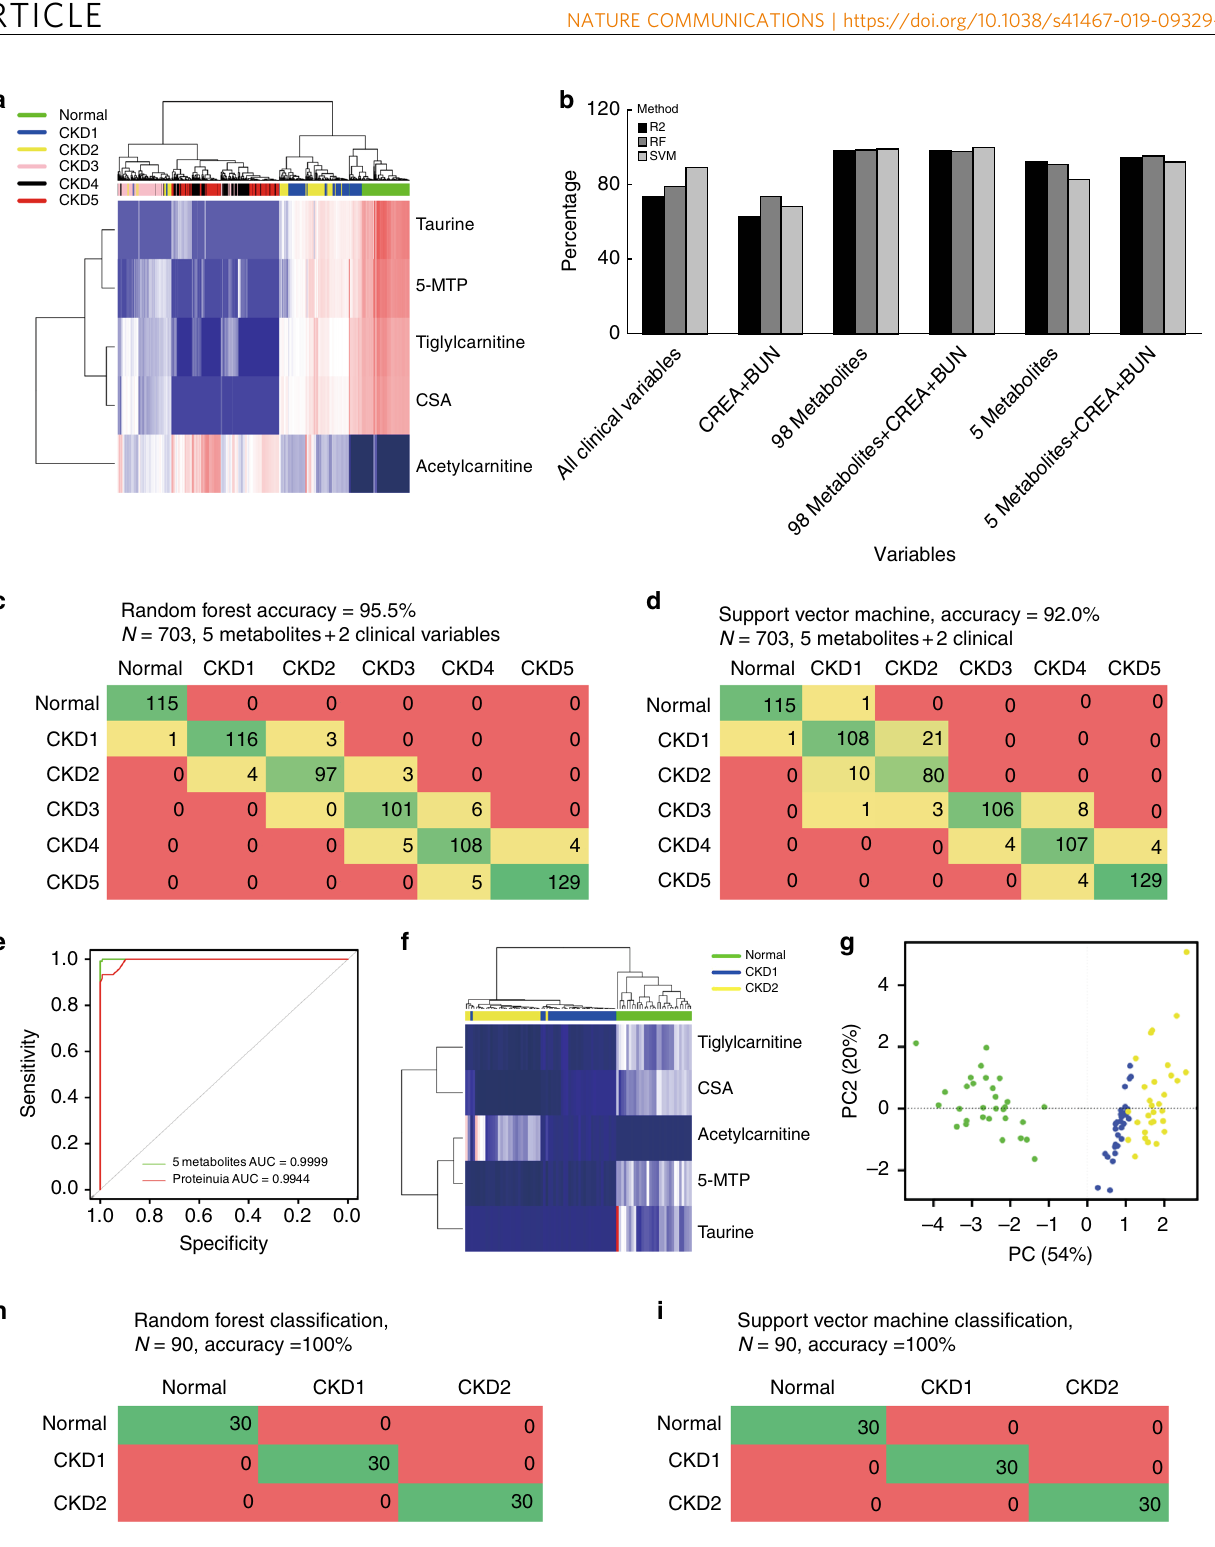
enalapril treatment. However, proteinuria was signi fi cantly improved after the treatment with enalapril (Fig. 4a, b), indicating therapeutic bene fi t of enalapril treatment. Except for taurine, the other four potential metabolites were signi fi cantly restored after patients received an enalapril treatment. Although eGFR did not change signi fi cantly during the 6-month treatment study, the fi ve metabolites were signi fi cantly altered, which indicated the higher sensitivity of fi ve metabolites than eGFR in early stage of CKD.